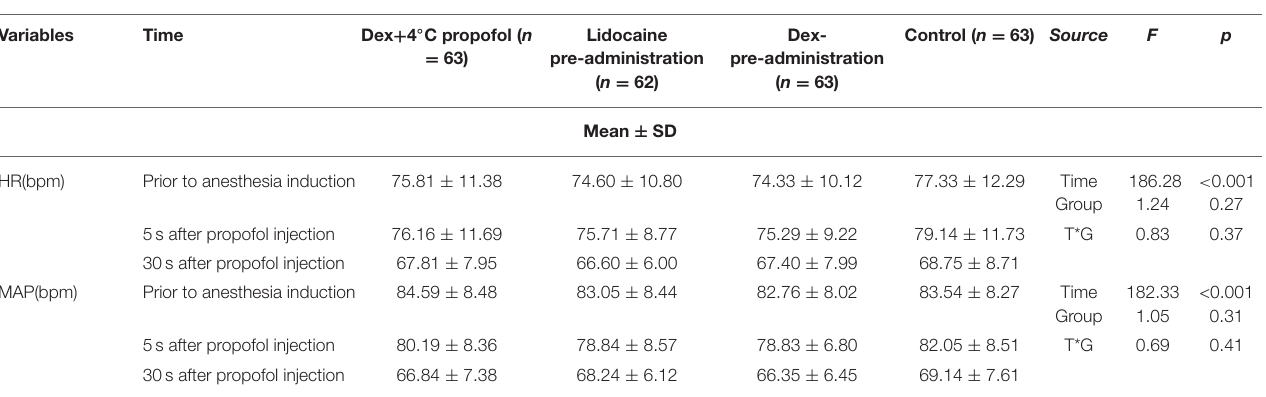
TABLE 4 | Comparisons of Hemodynamic parameters between groups ( n =